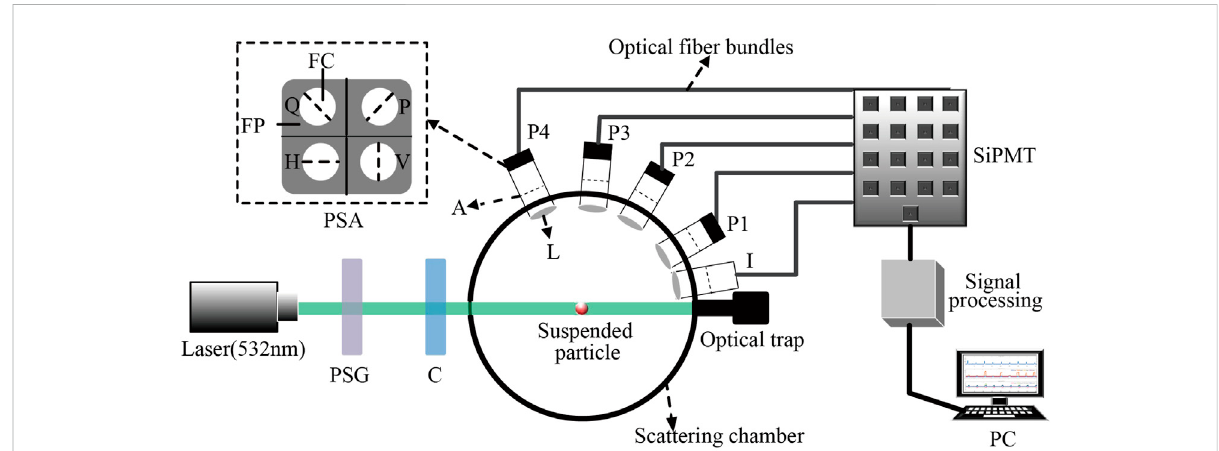
FIGURE 1 Schematic diagram of the single particle measurement method for suspended particulate matter in the atmosphere. PSG, polarization state generator; C, cylindrical lens; I, light intensity channel (10 ° ); L, biconvex lens; A, aperture; P1-P4, polarization state analysis channel for 30 ° , 60 ° , 85 ° , 115 ° , respectively; PSA, polarization state analyzer; FP, polarizer fi lm; FC, fi ber core; H, horizontal polarizer fi lm; V, vertical polarizer fi lm; P, 45 ° polarizer fi lm; Q, 135 ° polarizer fi lm; SiPMT, silicon photomultiplier tube; OPS, optical particle